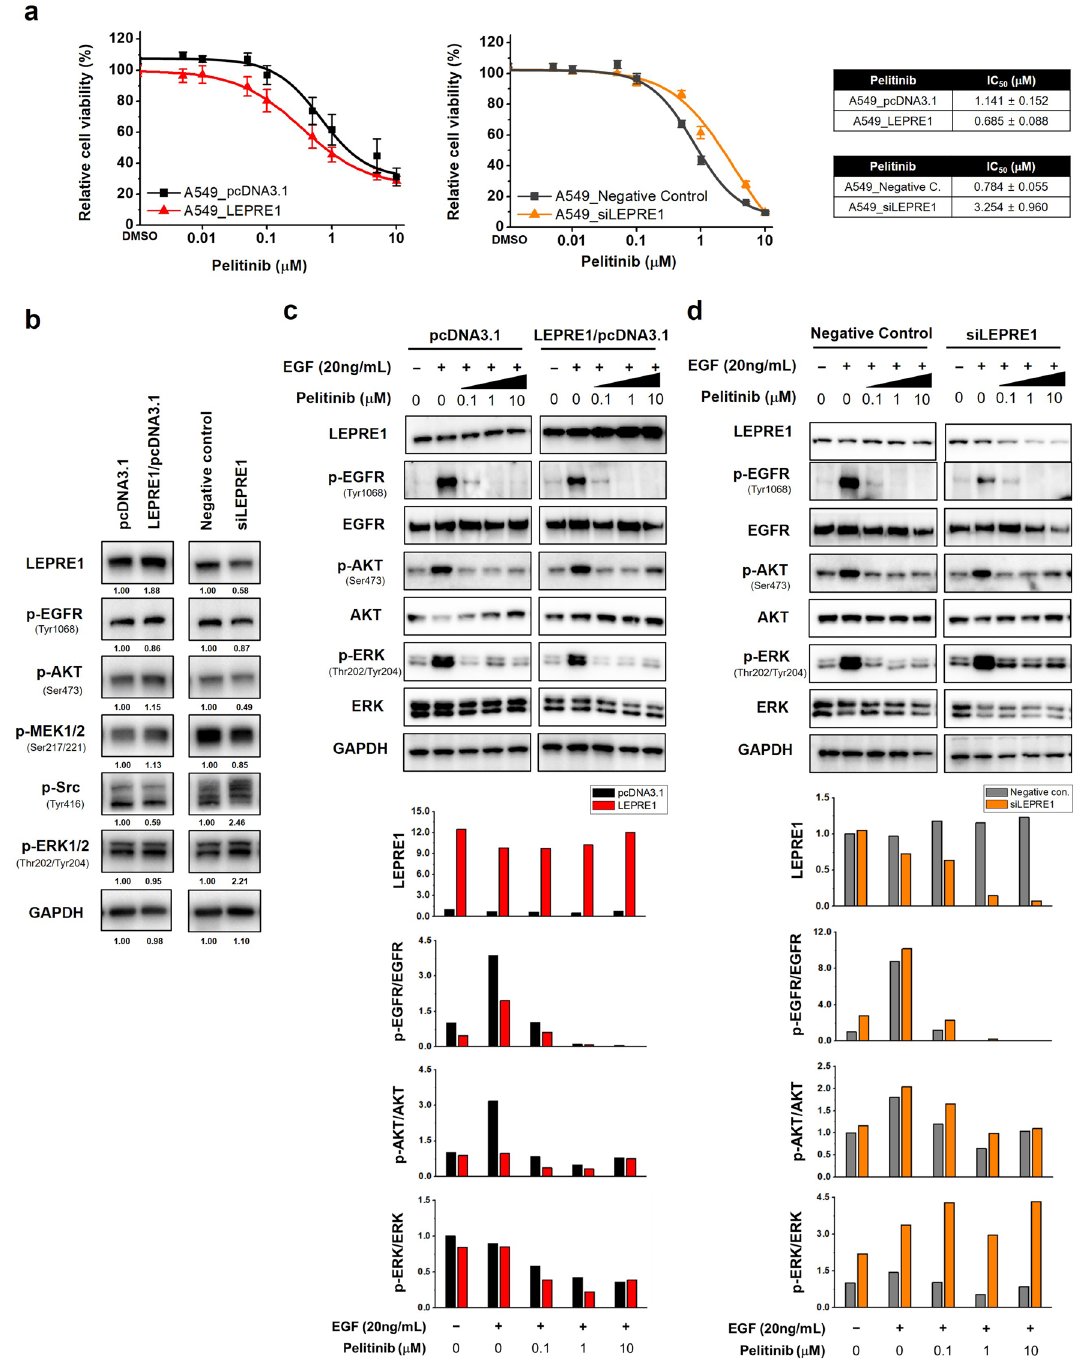
Figure 4. LEPRE1 regulates drug responsiveness in lung cancer-derived A549 cells. (a ) LEPRE1 overexpression (left side) or LEPRE1 knockdown (right side) A549 cells were treated with pelitinib for 3 days. Cell viability was determined using WST-1 proliferation assays. ( b ) A549 cells were transfected with pcDNA3.1 and LEPRE1/ pcDNA3.1 or with Negative control siRNA and LEPRE1 siRNA, as indicated. After 48 h, EGFR, AKT, and ERK expression were determined by western blot analysis. ( c , d ) A549 cells were transfected with pcDNA3.1 and LEPRE1/pcDNA3.1 ( c ) or with Negative control siRNA and LEPRE1 siRNA ( d ) and then treated with EGF and/or the indicated concentration of pelitinib (0, 0.1, 1, 10 μM) for 24 h. Cell extracts were prepared and immunoblotted using the indicated antibodies. GAPDH was used as an internal control. All western blots are pre-cut. Membranes were often stripped and reprobed for multiple